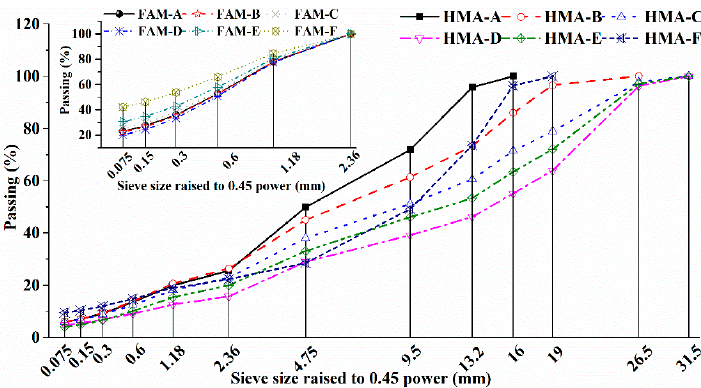
Figure 3. Gradation curves for six types of HMA and the corresponding FAM.